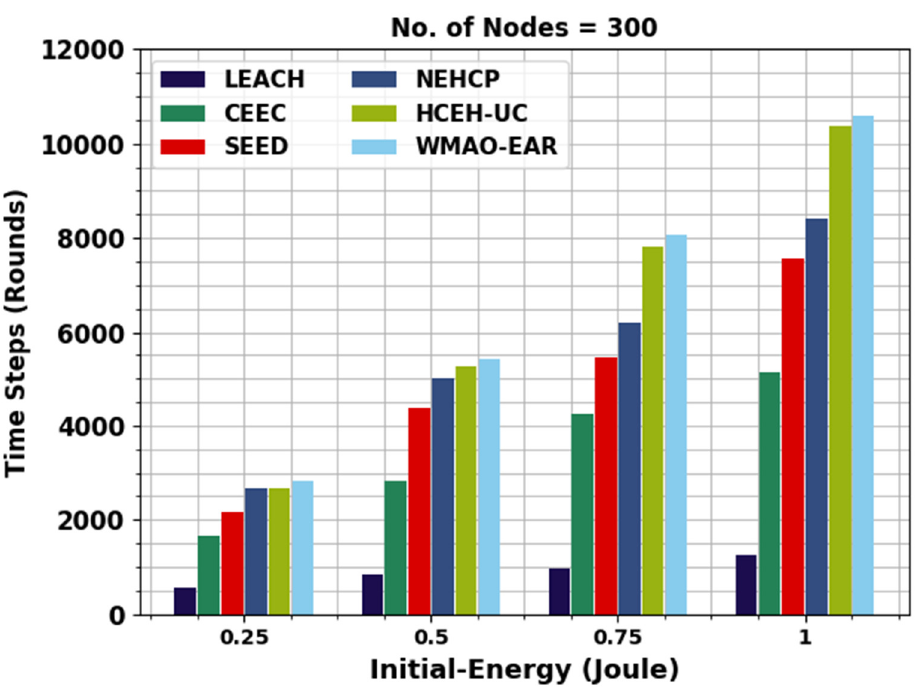
Figure 6. EU analysis of WMAO-EAR approach under NC of 300.